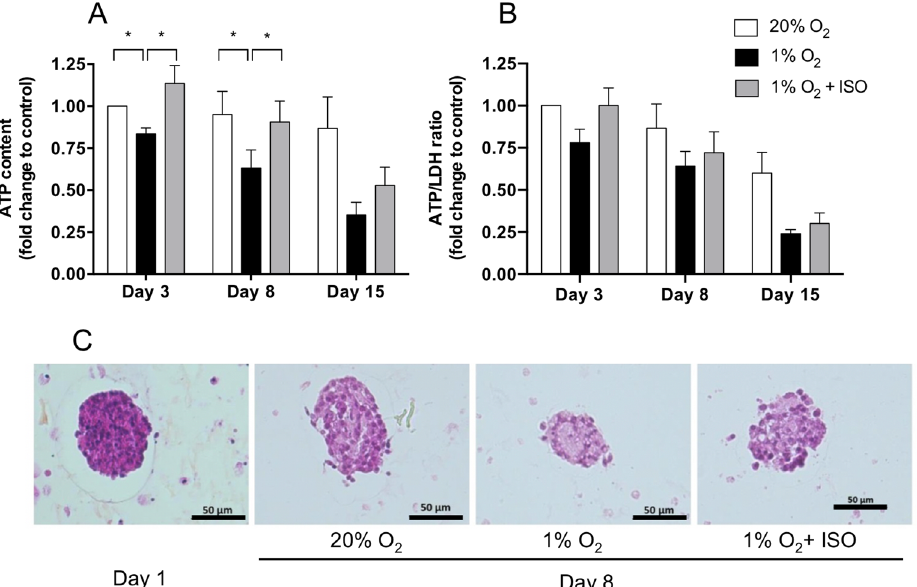
Figure 4. Viability of neonate pig islets embarked in O 2 -balanced BAP. Alginate encapsulated NPIs (3000 IEQ/150 µL) were cultured for 3, 8 and 15 days under normoxic condition (20% O 2 , positive control, white bar) or hypoxic condition without O 2 strategy (1% O 2 , negative control, black bar) or with the innovative strategy of oxygenation (ISO) composed of silicone-CaO 2 disk and 500 µg/mL HEMOXCell by alginate (1% O 2 + ISO, grey bars). Fold change in ( A ) total metabolic activity (ATP content, RLU) and in ( B ) viability (ATP/LDH ratio, RLU/AU) of encapsulated NPIs compared to the control cultured at day 3 under 20% O 2 without O 2 strategy. Results from independent experiments (n = 4–6) are expressed as mean ± SEM ( A , B ). *p < 0.05 (Non-parametric Wilcoxon apparatus test). ( C ) Histological analyzes of formalin-fixed paraffin-embedded NPIs 4 µm thick cross- sections stained with hematoxylin–eosin-saffron on pre-encapsulated NPIs, 24 h after isolation (day 1) and on decapsulated NPIs after 8 days of culture within the BAPs